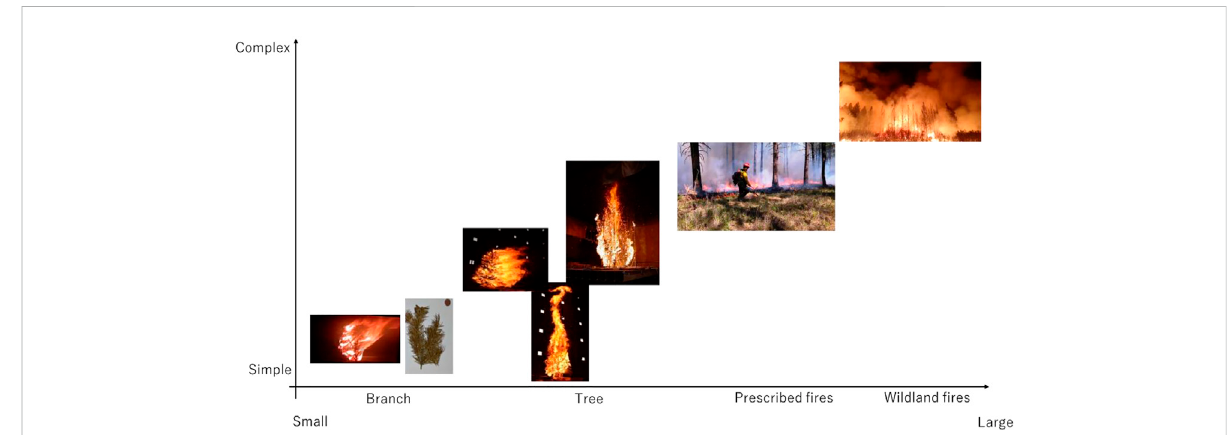
FIGURE 8 Firebrand generation from vegetation — actual-scale to simple, smaller-scales (image credit right to left, Rim fi re (Wikipedia), Ken Meinhart (USFWS), Manzello et al., 2007, Suzuki and Manzello 2022c, and Hajilou et al.,